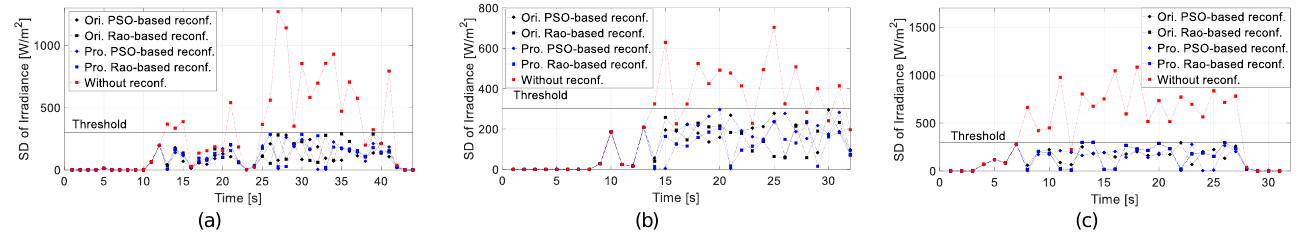
Figure 20. Comparison of SDI of TCT-configured, original-PSO-reconfigured, original-Rao-reconfigured, proposed-PSO-reconfigured, and proposed-Rao-reconfigured PV arrays under three shading cases without lagged time. ( a ) Case 1. ( b ) Case 2. ( c ) Case 3. (a)